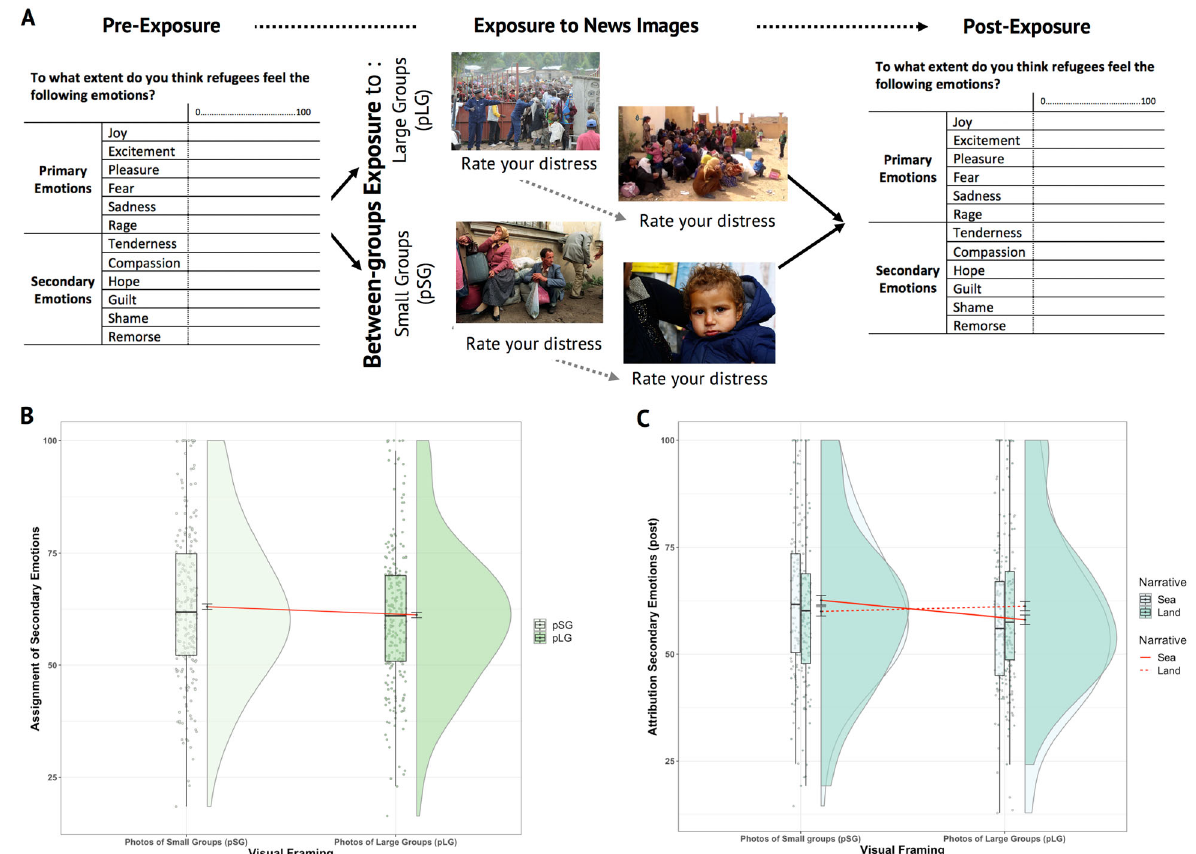
Fig. 1 Experimental design and results of studies 1 and 2. A Between-subjects design, Study 1. Pre- and post-exposure to images, participants completed a dehumanization questionnaire that considers the extent to which refugees feel each primary and secondary emotion, by providing a rating using a VAS scale (0 — not likely at all; 100 — extremely likely). Images depicted here are illustrative examples of the visual framing (i.e. were not presented in any of our studies) Source: Wikimedia Commons, top left link , top right link , bottom left link , bottom right link . B Study 1: Raincloud plot with fi tted values of the main effects of Framing on attribution of Secondary Emotions. Y -axis = Assignment of Secondary Emotions after exposure to photographic images. Dots represent single data points; boxplots and half violin plots represent mean and probability distribution according to the condition. Red lines, black points and error bars (SEM) represent fi tted values of the main effect of Framing on attribution of secondary emotions. After exposure to pLG of refugees, participants attributed signi fi cantly ( p < 0.05) fewer secondary emotions to refugees in comparison to pSG. C Study 2 tested four independent groups of participants, re fl ecting the 2 × 2 between-subjects design of Visual Framing (Large or Small Groups) × Narrative (at the Sea or on Land). Raincloud plot with fi tted values of the main effects of Visual Framing on Assignment of Secondary Emotions in function of the Narrative. Y -axis = Assignment of Secondary Emotions after exposure to photographic images of (refugees). Dots represent single data points; boxplots and half violin plots represent the mean and probability distribution according to the condition. Red lines, black points and error bars (SEM) represent fi tted values. After exposure to pLG of refugees, participants attributed signi fi cantly ( p < 0.05) fewer secondary emotions in comparison to pSG when refugees were depicted at Sea (light green, straight red line) rather than at Land (dark green, dotted red